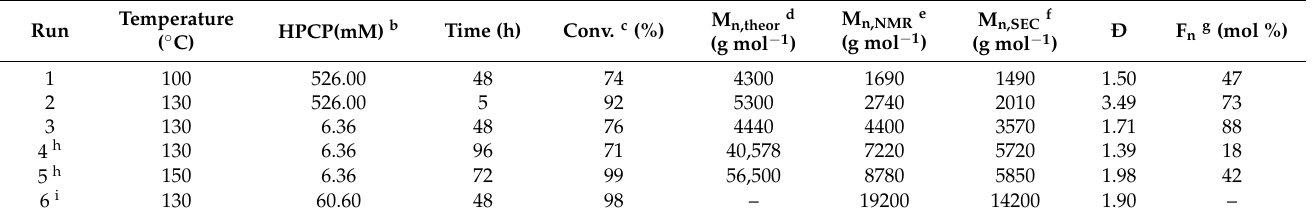
Table 1. Ring-opening polymerization of ε -caprolactone catalyzed by HPCP in bulk at different temperatures, catalyst and initiator concentrations a